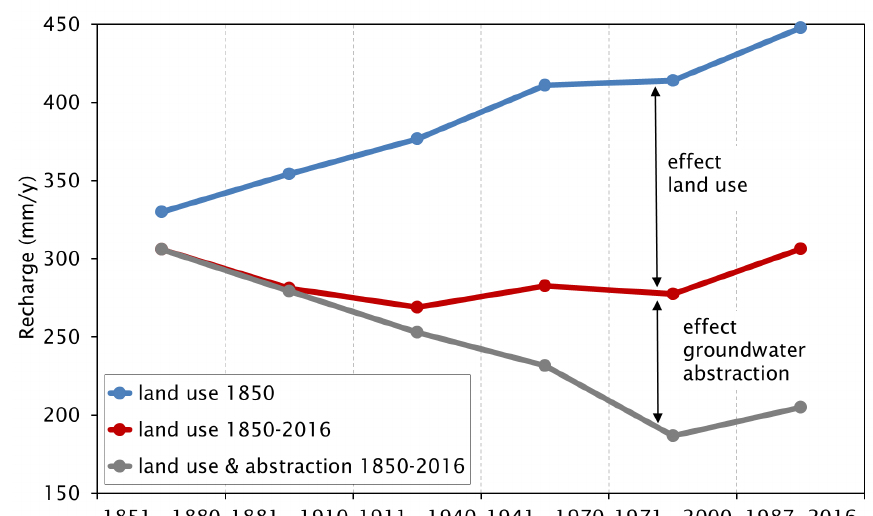
Figure 8. Groundwater recharge for the historical period based on three different scenarios: scenario with actual evaporation (ET act ) based on land use 1850, scenario with ET act based on actual land use, scenario with ET act with actual land use and including groundwater abstractions.